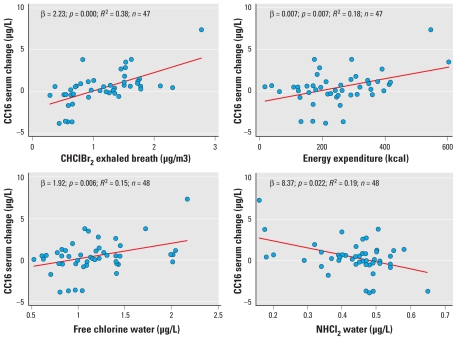
Correlation between the change in serum CC16 concentration and dibromochloromethane (CHClBr2) in exhaled breath, energy expenditure during swimming, free chlorine in water, and dichloramine (NHCl2) in water.